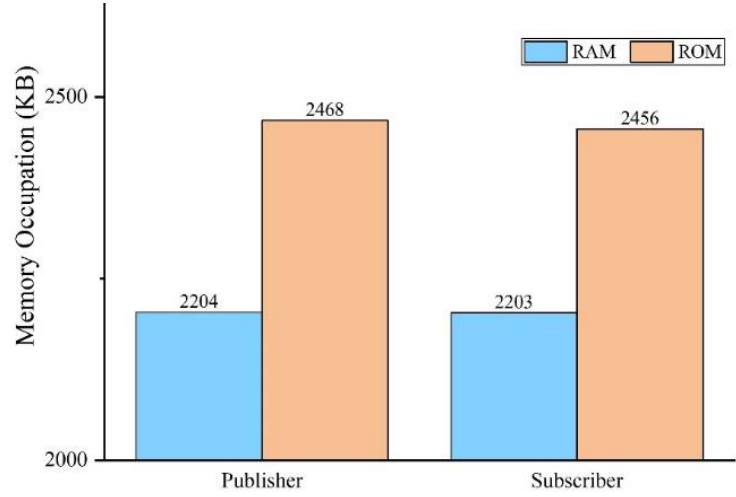
Figure 13. Memory occupancy of publisher and subscriber.